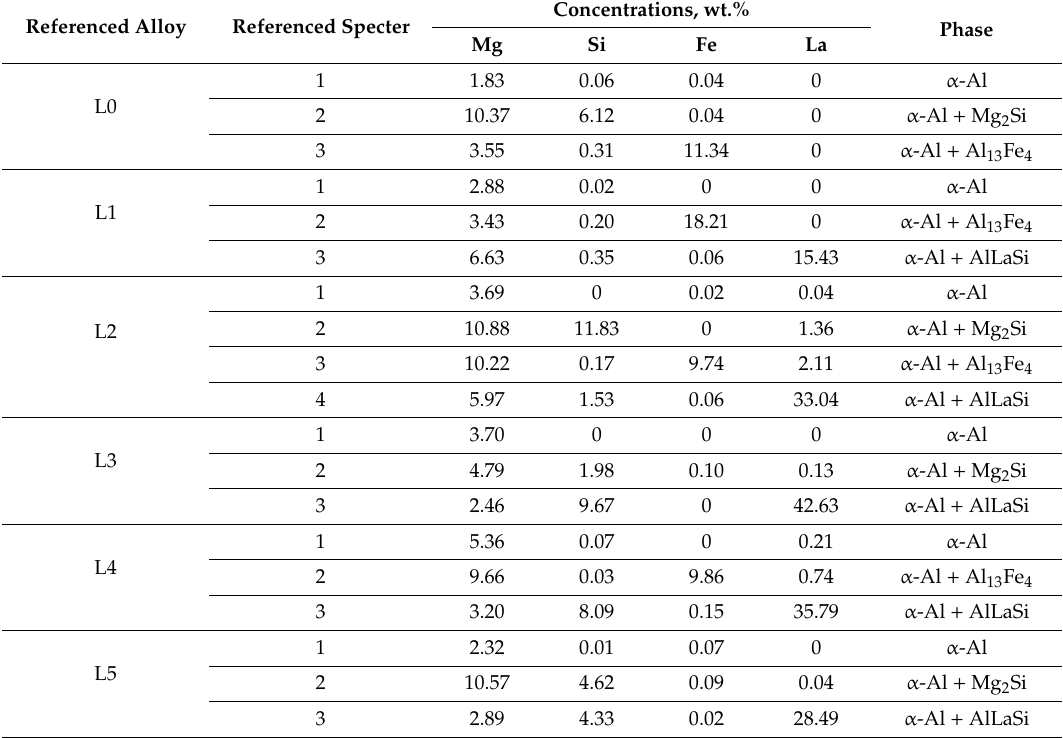
Table 3. Chemical composition of the microstructural components in experimental alloys according to electron microprobe analysis (EMPA) 1